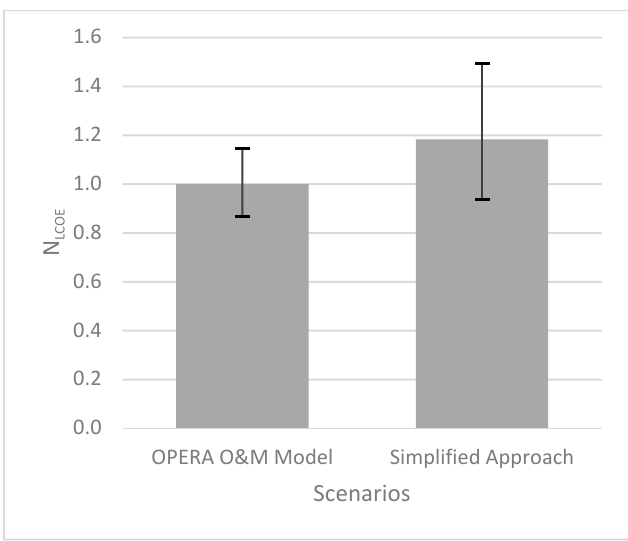
Figure 8. Normalised LCOE for the OPERA O&M Model and Simplified Approach . Error bars show the uncertainty range between results.